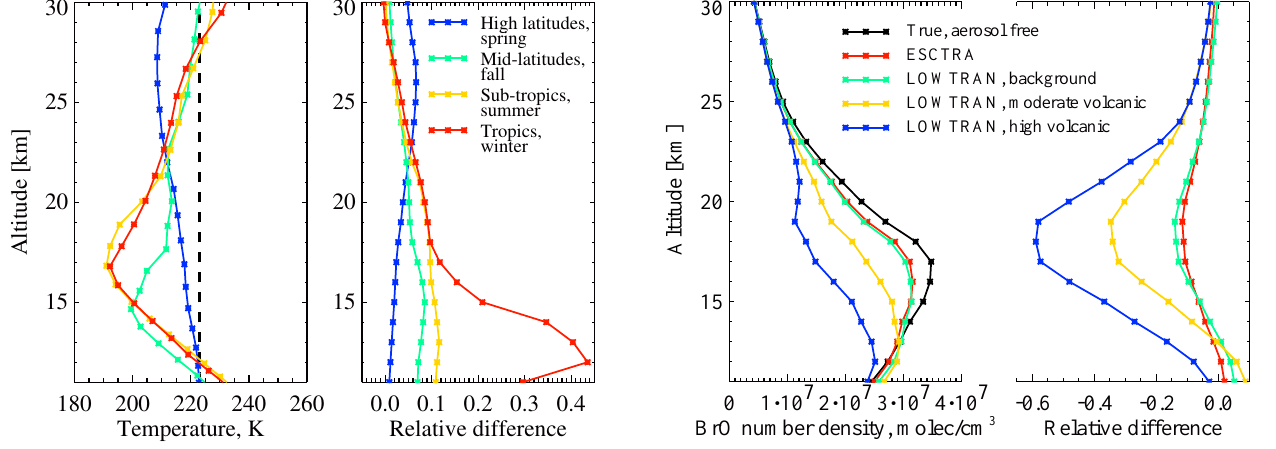
Fig. 17. Influence of stratospheric aerosols on the retrieved verti- cal profiles of BrO for a typical observation over Northern Sweden during high-latitude spring. Left panel: true vertical profile of BrO (black line) and retrieval results for different aerosol loading sce- narios (color lines). Right panel: relative differences between BrO profiles retrieved for different aerosol loading scenarios and the true profile. The results are obtained with the IUP Bremen algorithm.